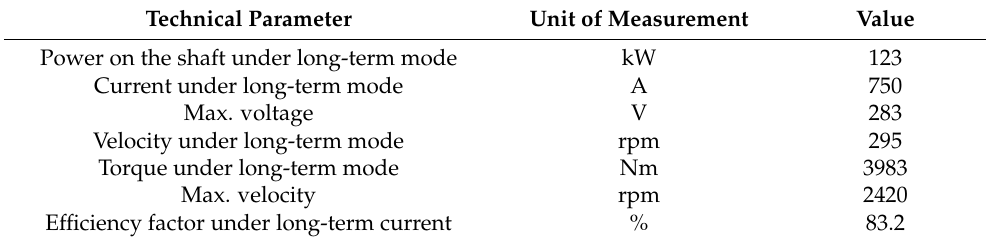
Table 2. Technical parameters of TE-006 electric motors in the operation modes of ChME3 locomotives.